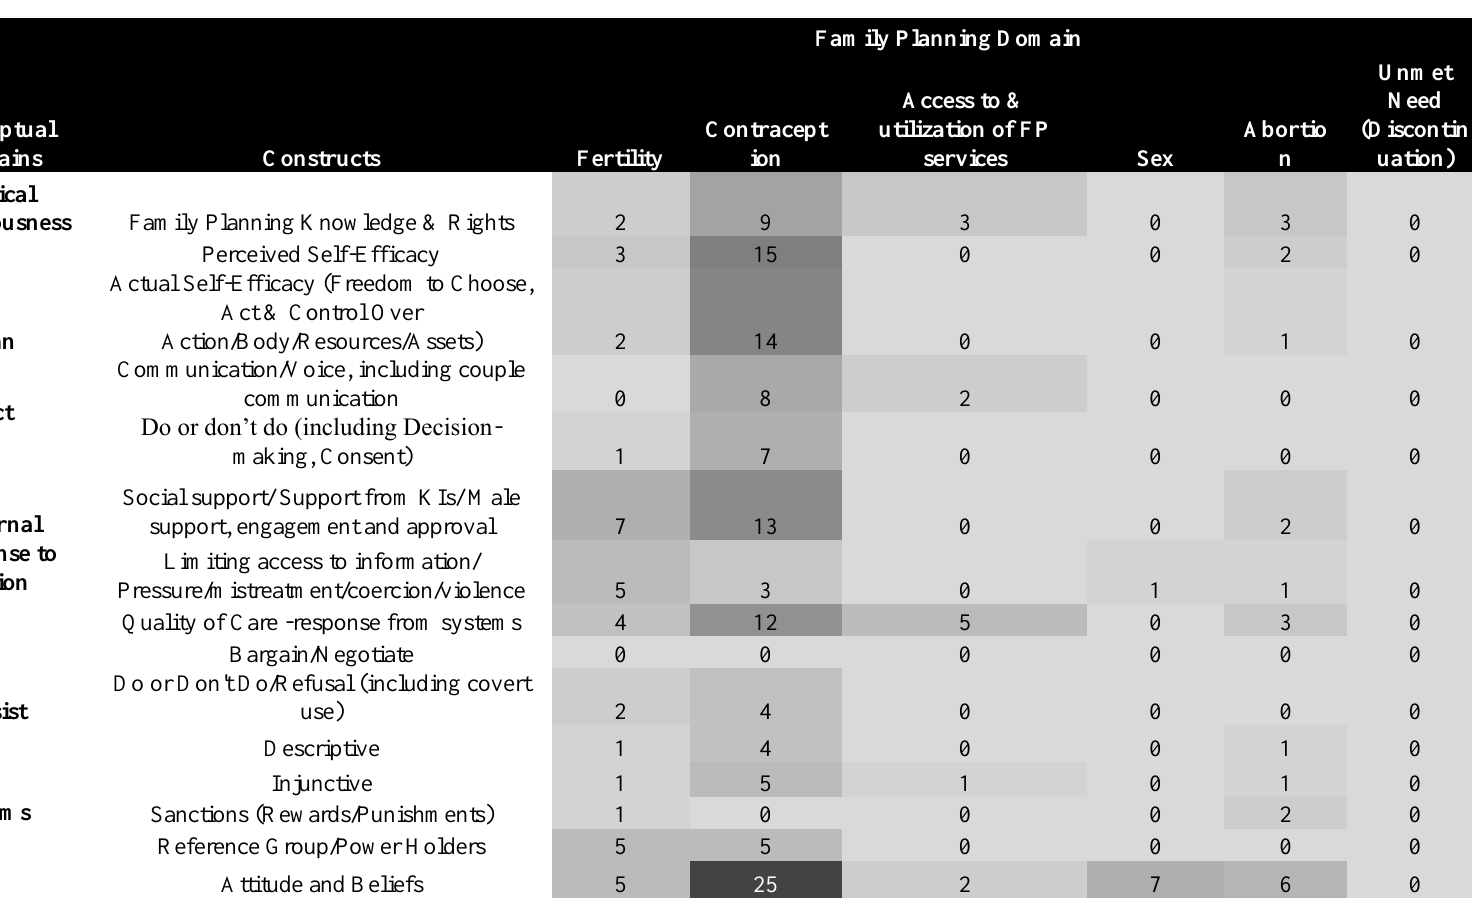
Table 3a: Heat Map of Measures from the Published Literature (2010-2020) on Gender Equity in Family Planning (n=152